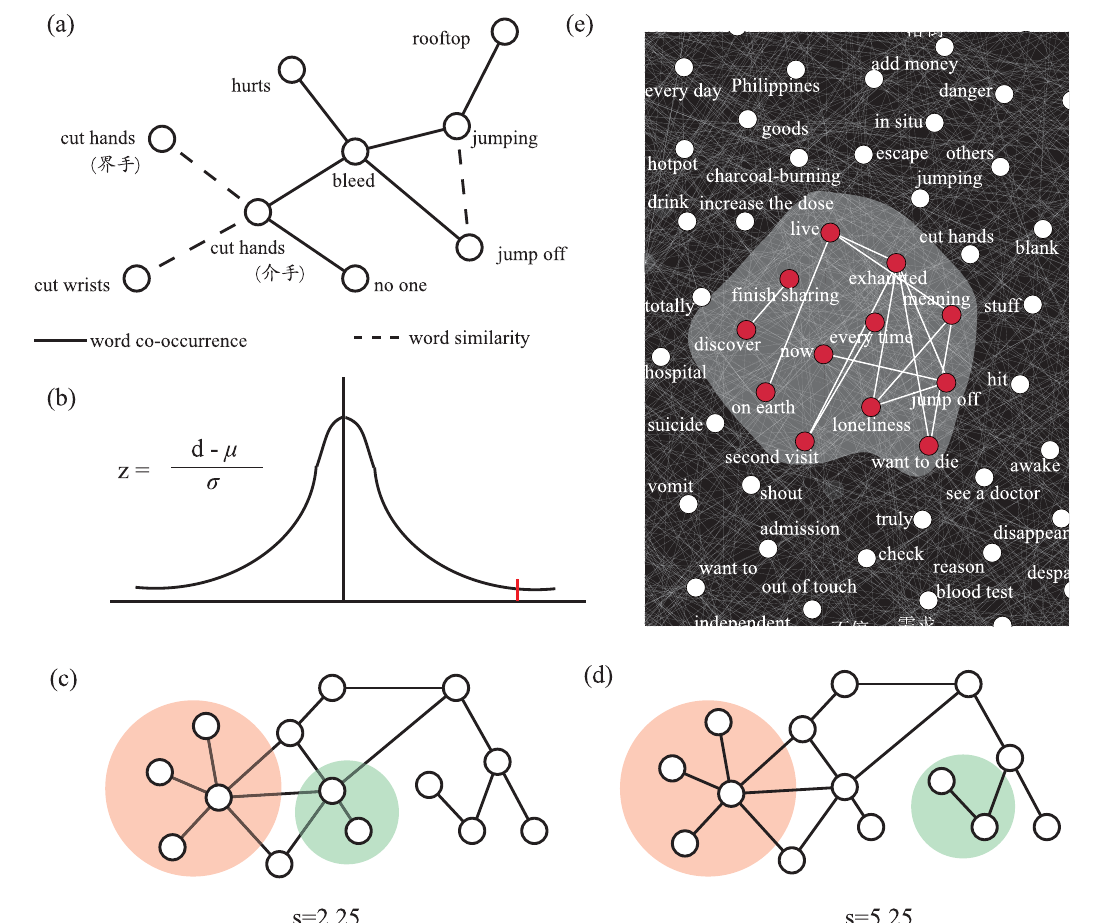
Fig. 1 The network-based transition point prediction method. a A subgraph of the word af fi nity network. Solid lines represent relationships of word co- occurrence, dash lines represent relationships of word similarity. In the rest of the paper, these two types of relationships are no longer visually discriminated for clearer presentation (i.e., solid lines for both types); b One-tailed z -test; c , d S-scores for two modules that are topologically closer or topologically distant. e Footprints of a block. Words within a block tend to form a connected subgraph, or a block module . See Supplementary Methods-D for the bilingual version of a , e